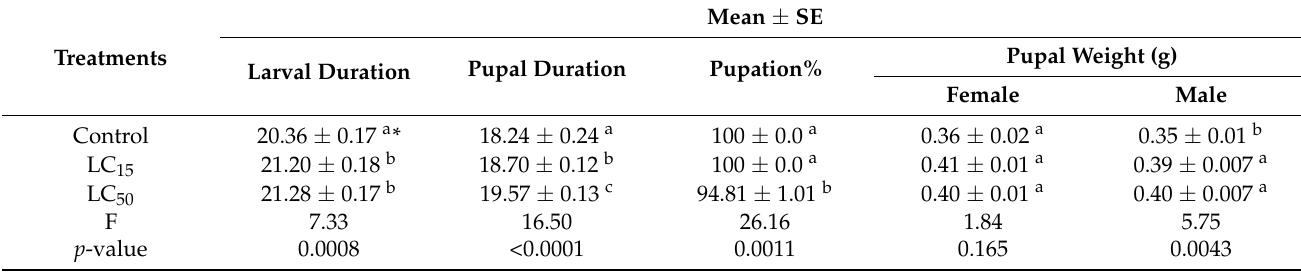
Table 3. Effects of C. citratus essential oil on the development of larval and pupal stages after treating the 2nd-instar larvae of Agrotis ipsilon with LC 15 and LC 50 values.